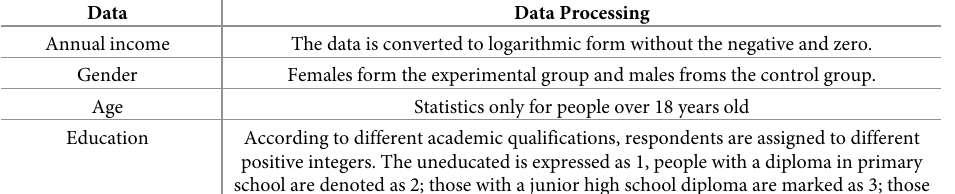
Table 1. Initial data